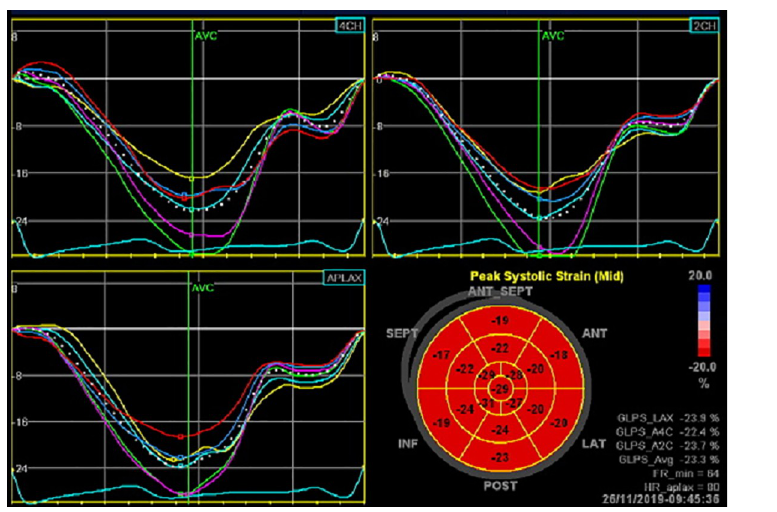
Fig 1. Global Longitudinal Strain (GLS)